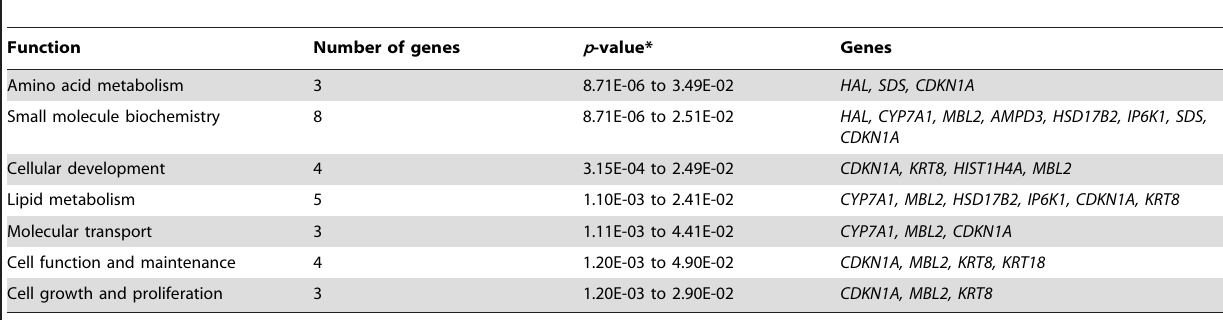
Table 6. Functional categories and corresponding DEGs in high androstenone liver tissues.